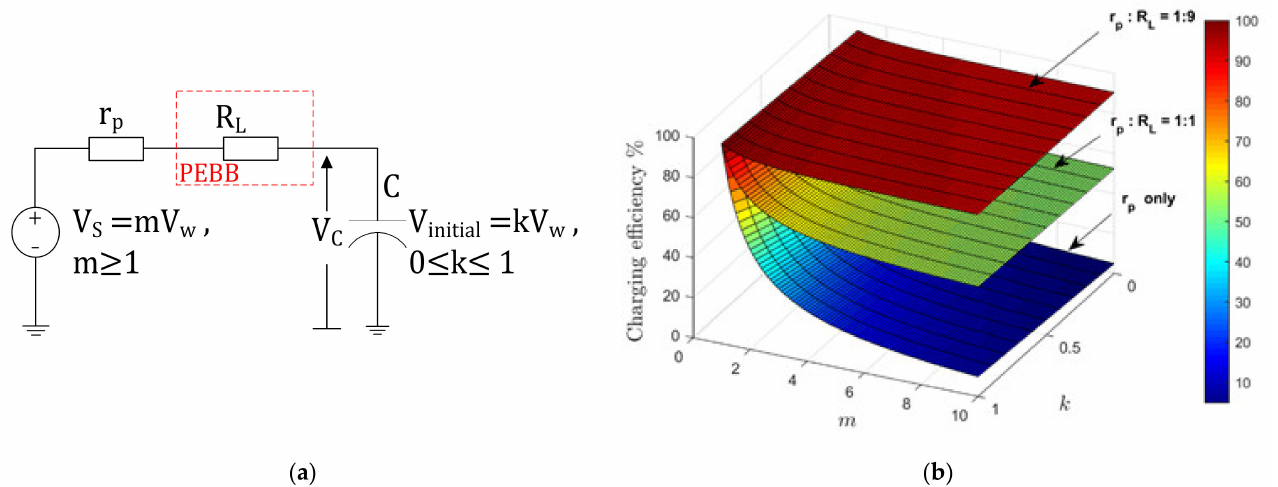
Figure 4. Insertion of a useful resistive load into the partially charging RC loop: ( a ) modified circuit with useful resistance R L ; ( b ) graphical representation of the circuit behavior in terms of efficiency versus variables m and k